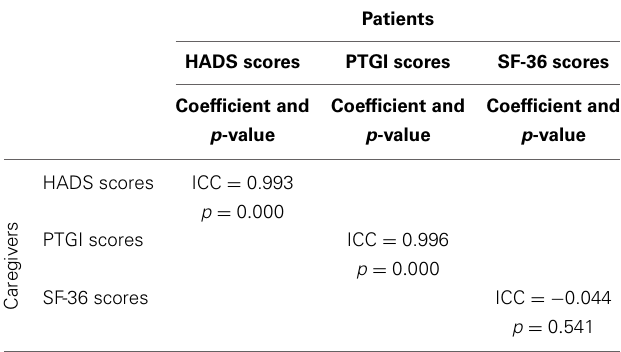
Table 5 | Intraclass correlations between HADS, PTGI and SF-36 scores of patients and